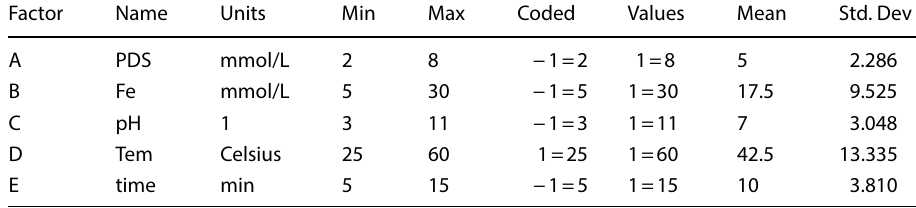
Table 1 Process variables and their actual and coded levels used for